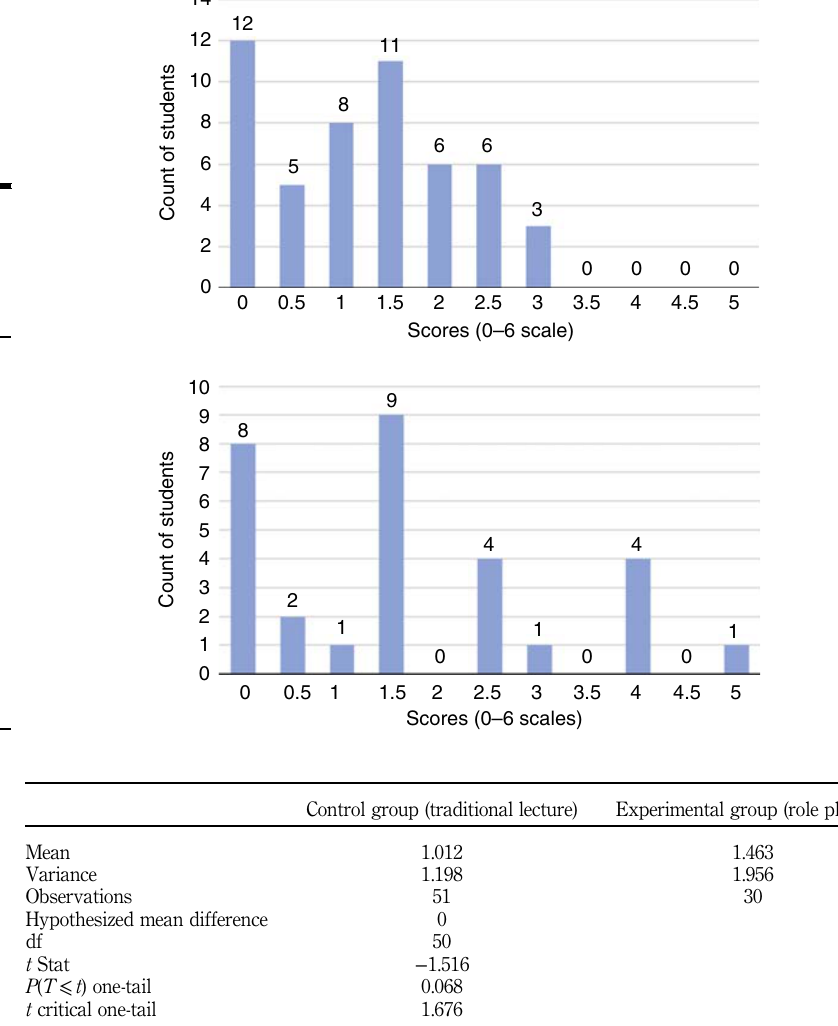
Table V. Comparison of groups – gain in knowledge (post- minus pre-test